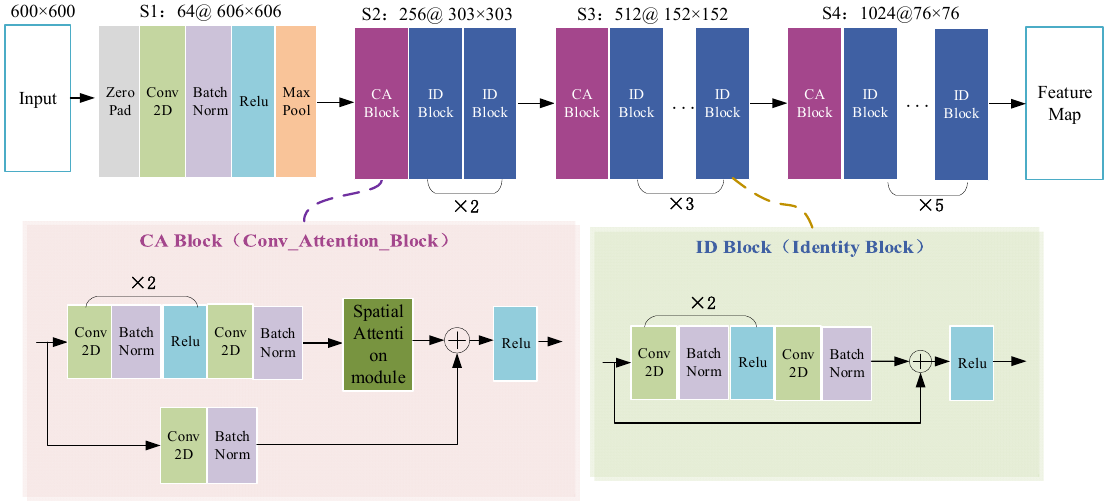
Figure 5. The architecture of the feature extraction module of RA-FasterRCNN.